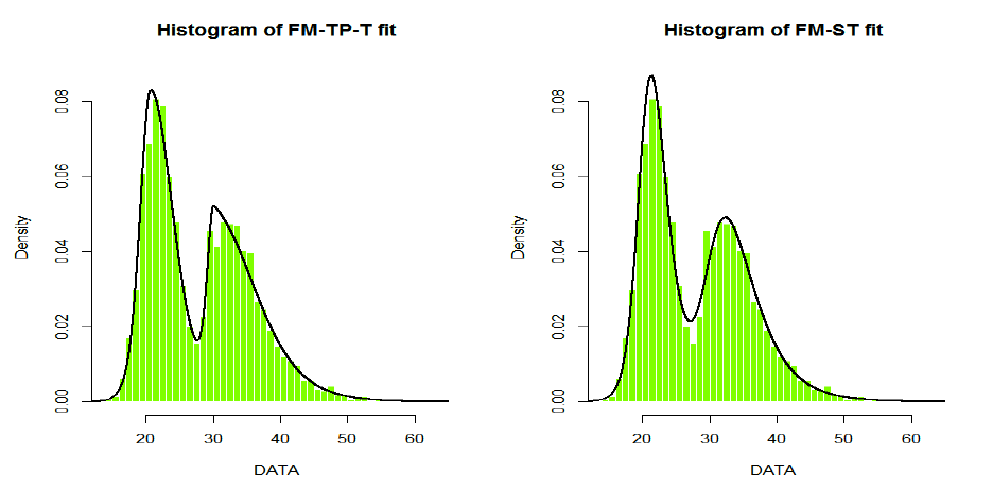
Figure 2. Histogram of body mass index (BMI) data with fitted FM-TP-true (T) ( left ) and FM-ST ( right ) models with two